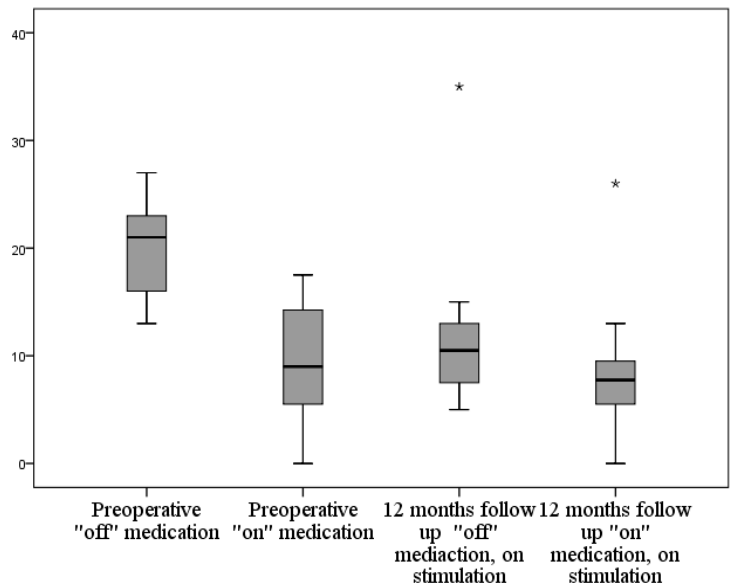
Figure 15. Graph showing the changes of UPDRS II score preoperatively and at 12-month follow-up in “on” and “off” medication conditions; UPDRS Unified Parkinson’s Disease Rating Scale.